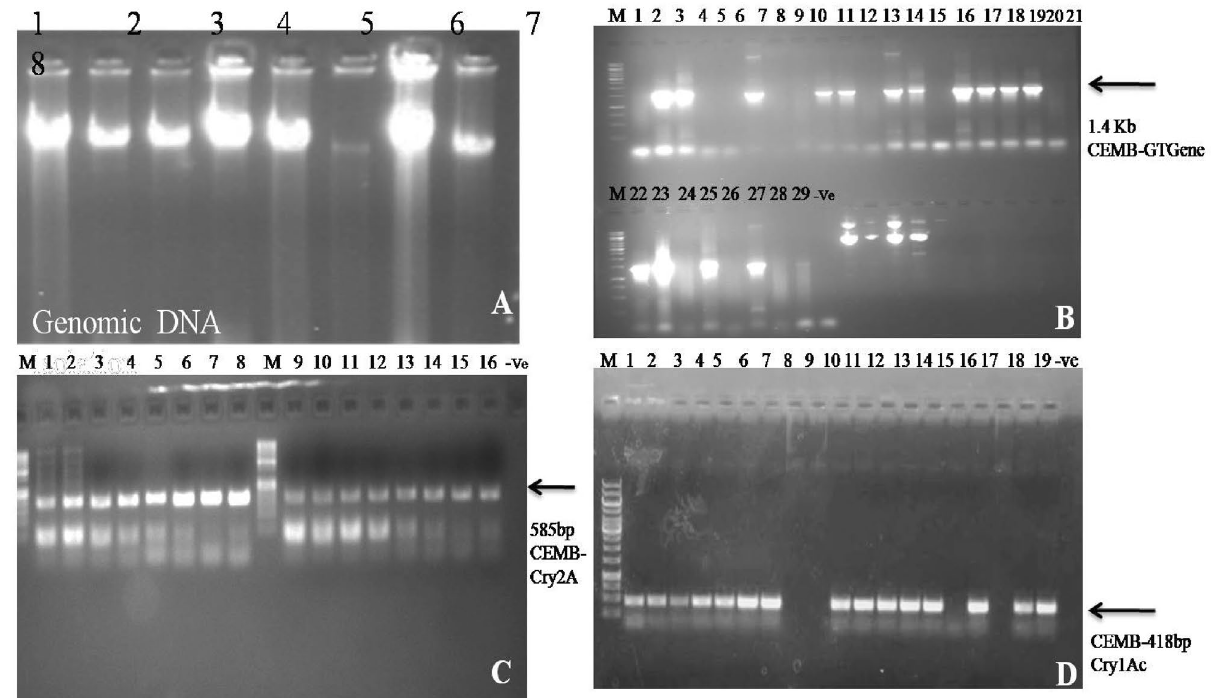
Figure 6. PCR screened positive plants of CPF-246 plant containing CEMB-GTGene, CEMB- Cry 2A and CEMB- Cry 1Ac. ( A ) Genomic DNA isolated from putative sugarcane plants. ( B ) Lane M: 1 kb DNA Ladder, Lane 1–28: Putative transgenic sugarcane plants with CEMB-GTGene Lane 29: Positive control, Lane −ve: Non- transgenic plant (control plant). ( C ) Lane M: 1 kb DNA Ladder, Lane 1: Positive control, Lane 2–16: Putative transgenic sugarcane plants with CEMB- Cry 1Ac Lane −ve: Non-transgenic plant (control plant). ( D ) Lane M: 1 kb DNA Ladder, Lane 1: Positive control Ladder, Lane 2–19: Screening of Putative transgenic sugarcane plants with CEMB- Cry 2Ac, Lane −ve: Non-transgenic plant (control